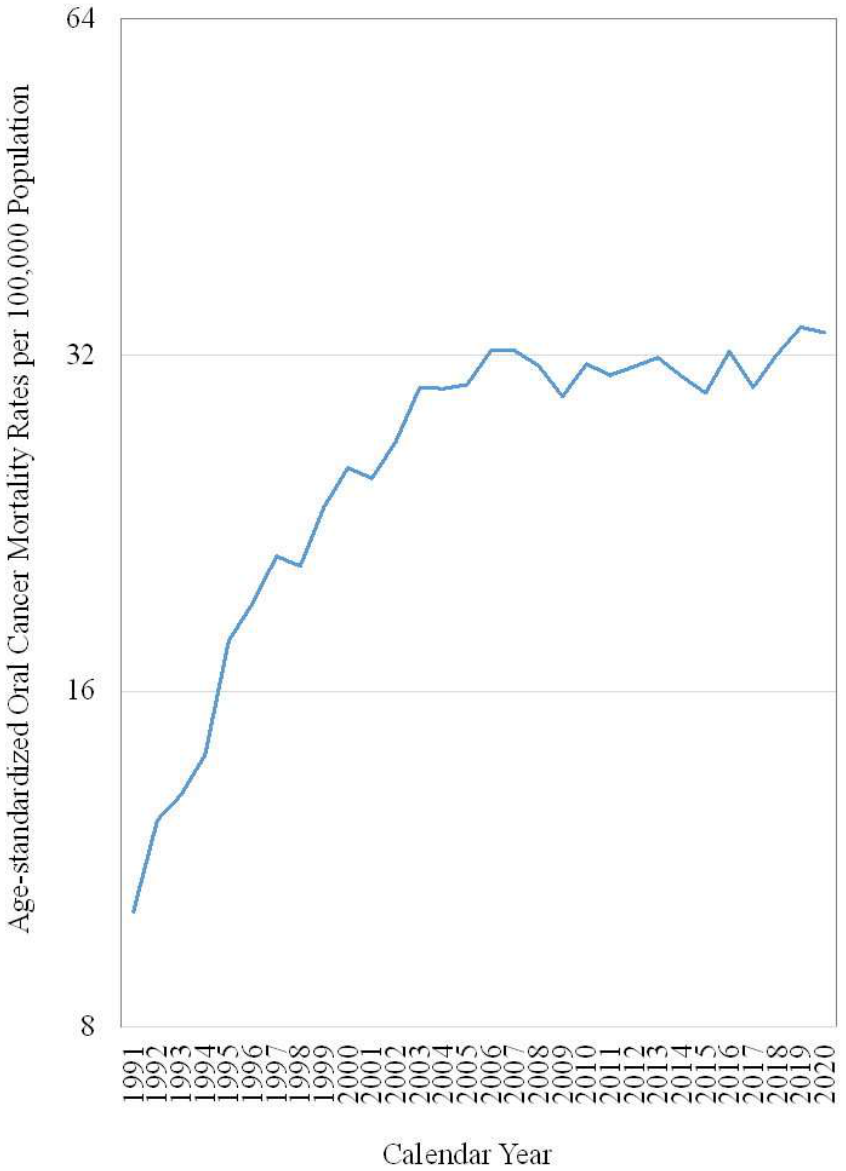
Figure 1. Age-standardized mortality rates of oral cancer in Taiwanses men between 30 and 64 years old from 1991 to 2020.